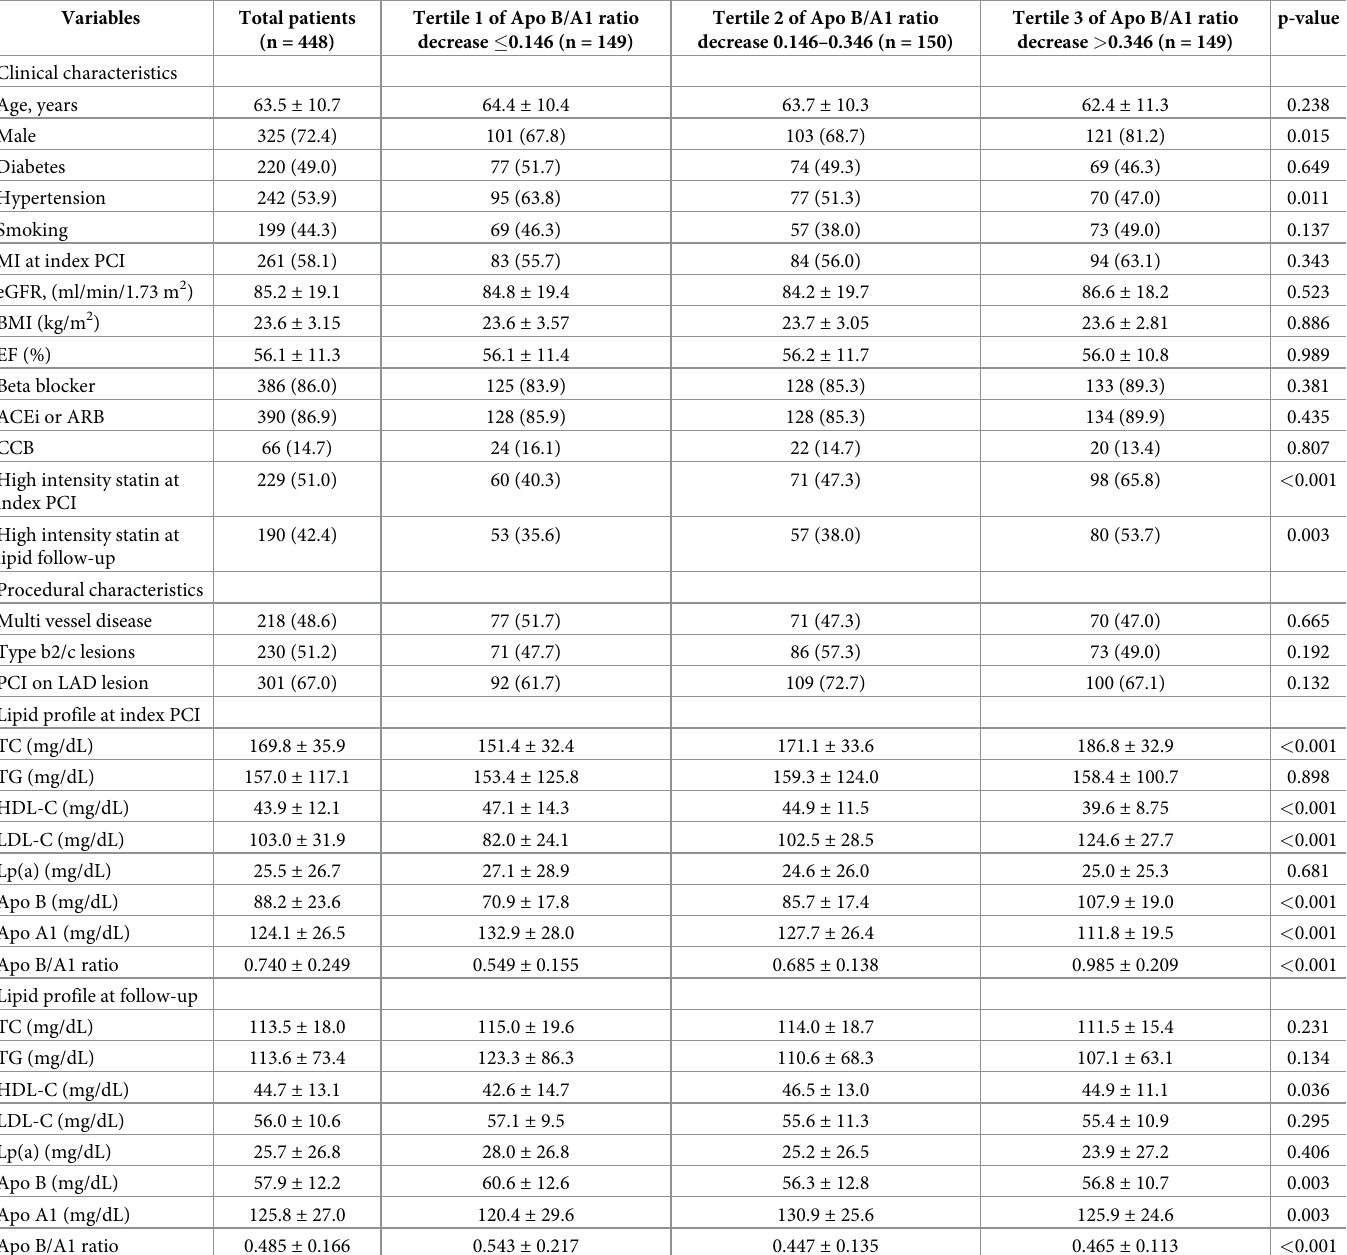
Table 1. Characteristics of individuals stratified by tertiles of Apo B/A1 ratio decrease. Variables Total patients (n =